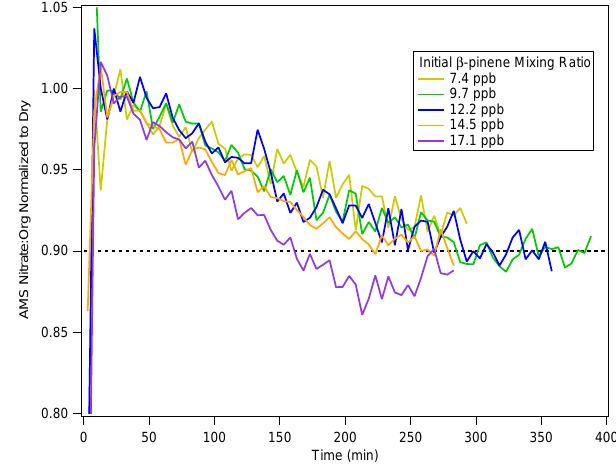
Figure 6. Time series of mass concentrations of the major organic families (normalized to the sulfate mass concentration) as measured by the HR-ToF-AMS at RH < 2% under “RO 2 + NO 3 dominant” conditions (Experiment 5 in Table 1). The least oxidized organic species (i.e., CH Family) decreases rapidly at the start of the exper- iment and has the largest decrease among the three major organic families.